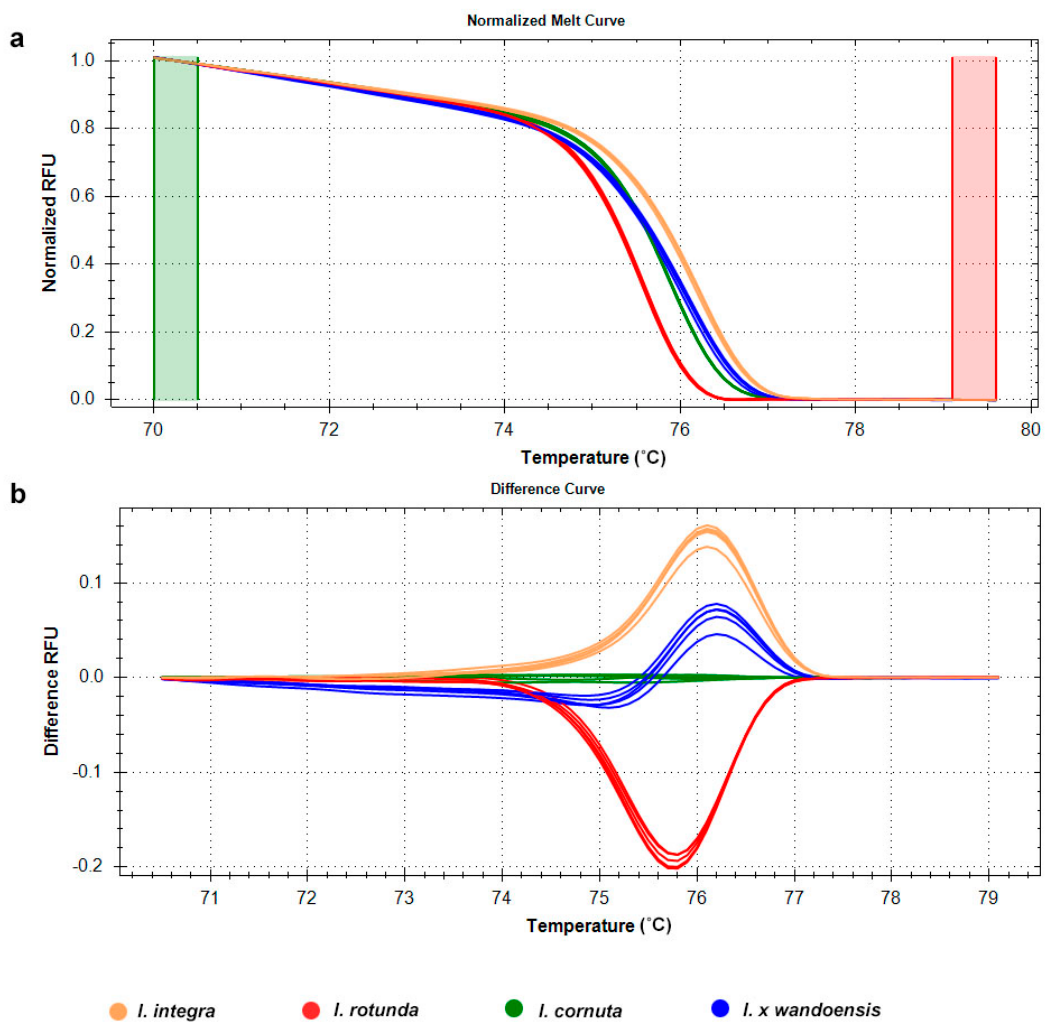
Figure 6. Microsatellite typing of the four Ilex species using HRM analysis with the SSR marker trnS UGA -psbZ . ( a ) Normalized melting curves. ( b ) Difference plot curves.